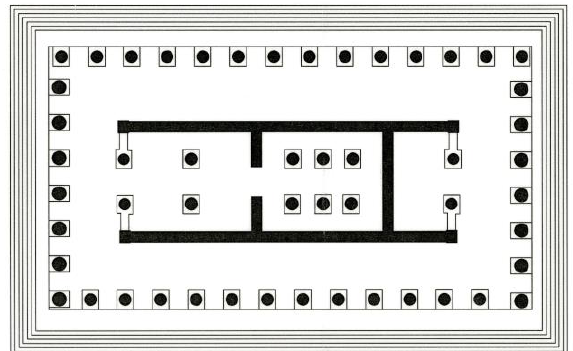
Figure 5. Ground plan of the temple of Artemis Leukophyrene at Magnesia.